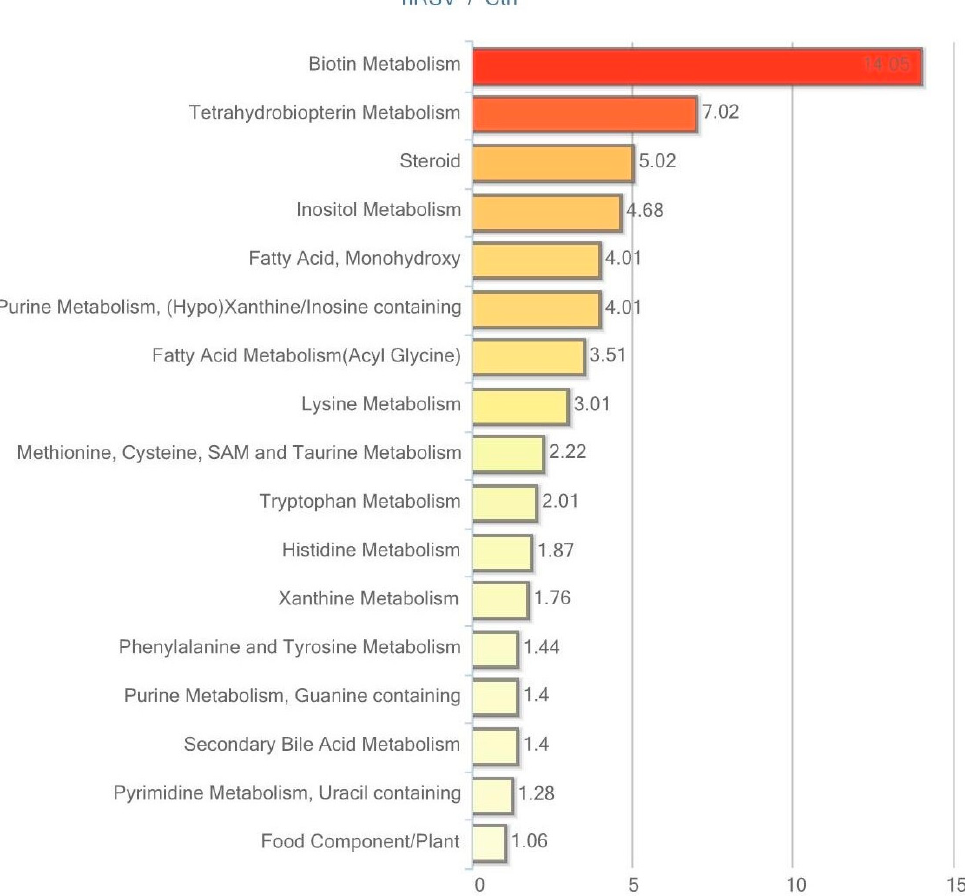
Figure 6. Resveratrol-mediated changes in urine expressed as Pathway enrichment values (PEV). Values are based on the significant resveratrol-regulated compounds relative to all detected compounds in the pathway. PEV = (number of significant metabolites in pathway/total number of detected metabolites in pathway)/(total number of significant metabolites/total number of detected metabolites); hRSV: high-dose resveratrol; Ctrl: Placebo group.